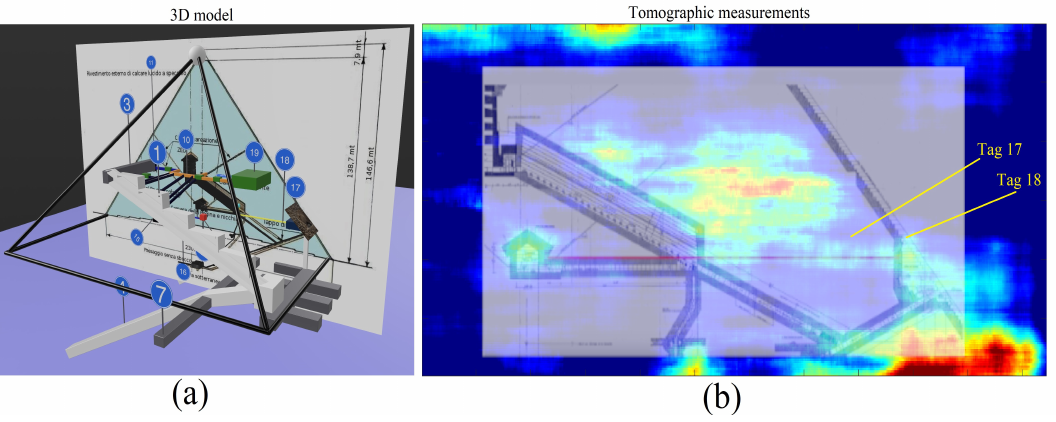
Figure 51. Tags association from tomography to 3D model. ( a ): Three-dimensional (3D) model of Khnum-Khufu. ( b ): Tomographic reconstruction